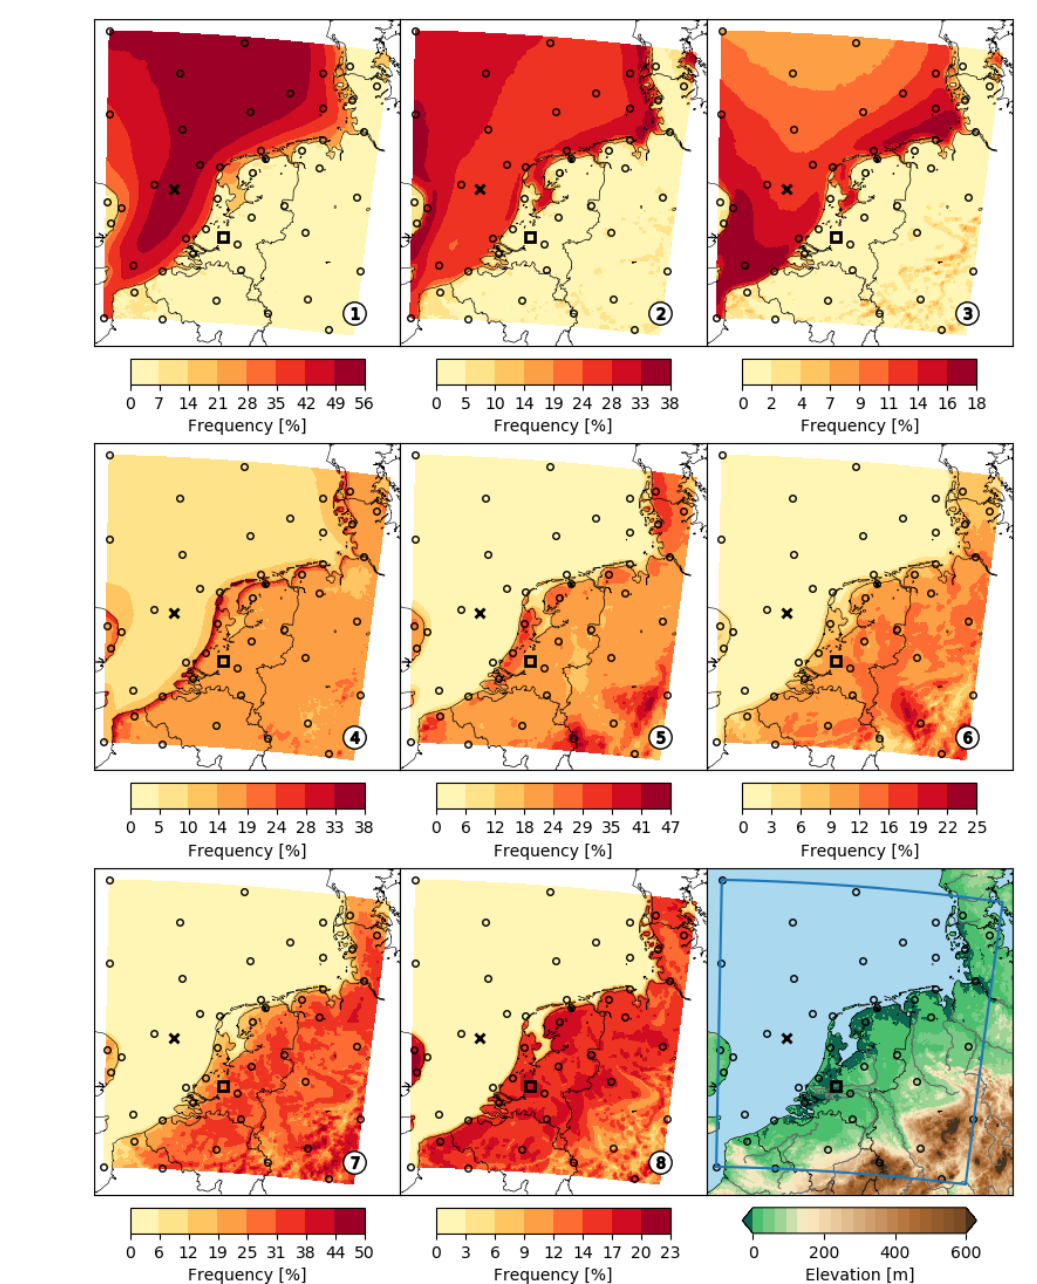
Figure 16. Frequency of occurrence of each multiple-location cluster (ML-1–8) mapped over the DOWA domain. The × and (cid:3) markers depict the reference locations of the met masts IJmuiden and Cabauw. The ◦ markers show the sampled grid points. The lower-right plot is a repetition of Fig.